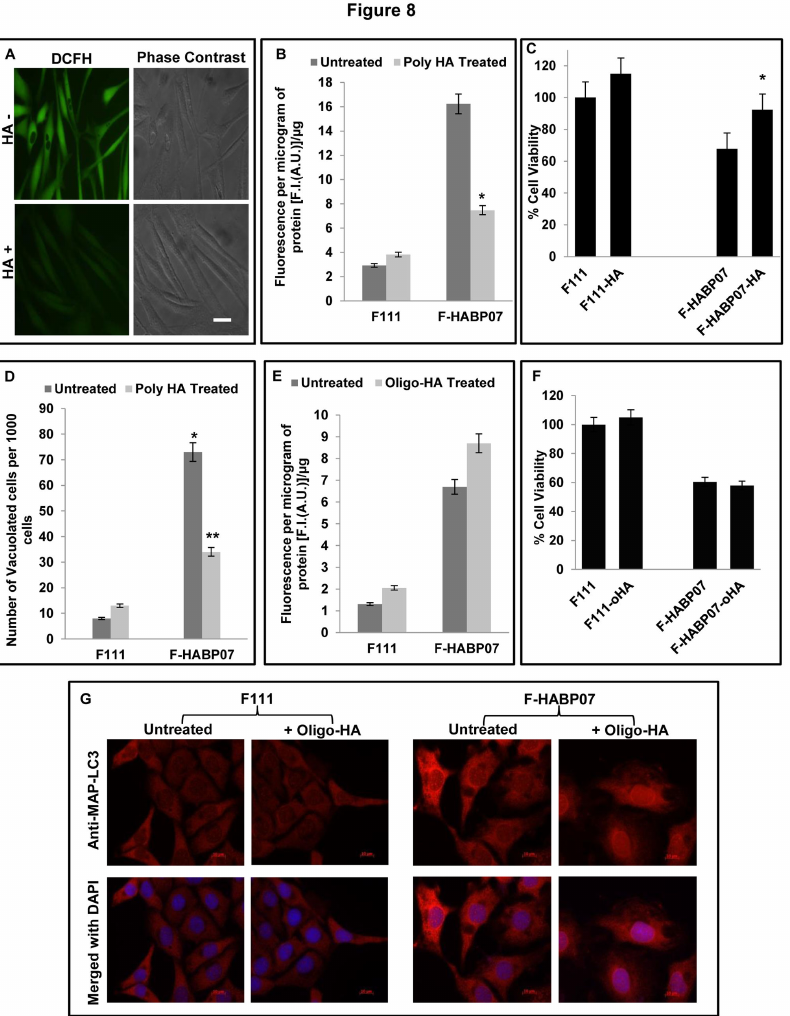
Figure 8. Reversal of ROS induced autophagic vacuole formation in F-HABP07 upon polymeric HA supplementation. [ A to D ] Polymeric HA supplementation restores cellular homeostasis in F-HABP07 cells -- As a result of significant reduction